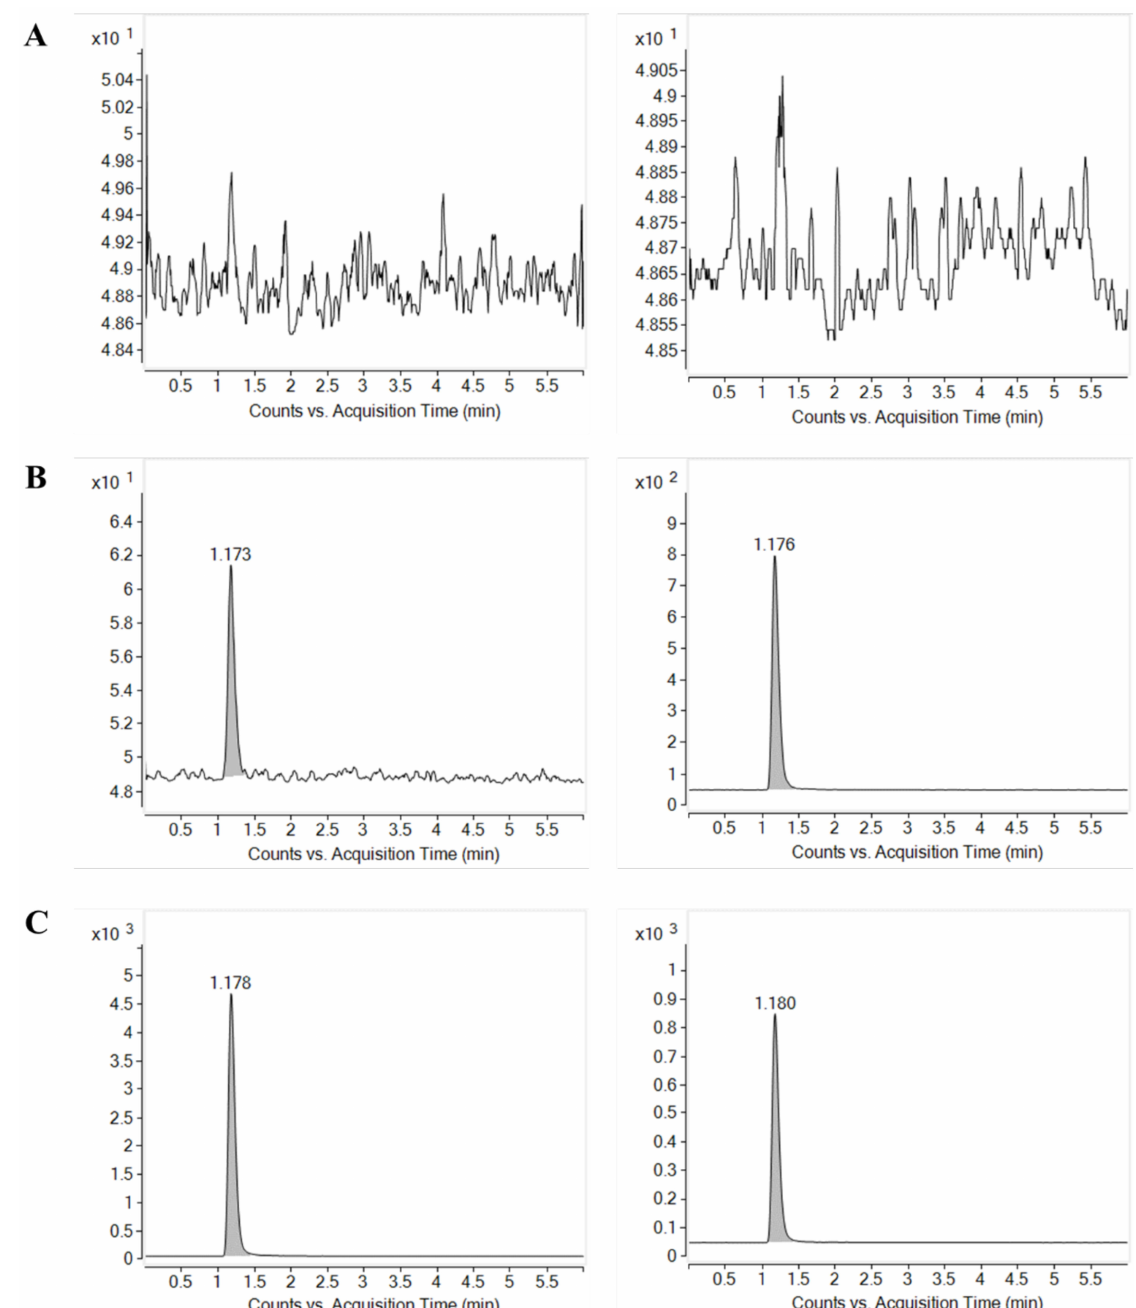
Figure 2. Multiple reaction monitoring (MRM) chromatograms of nafamostat (left) and IS (right) obtained from ( A ) blank rat plasma, ( B ) blank rat plasma spiked with LLOQ concentration of nafamostat (0.5 ng/mL) and IS, and ( C ) blank rat plasma spiked with ULOQ concentration of nafamostat (200 ng/mL) and